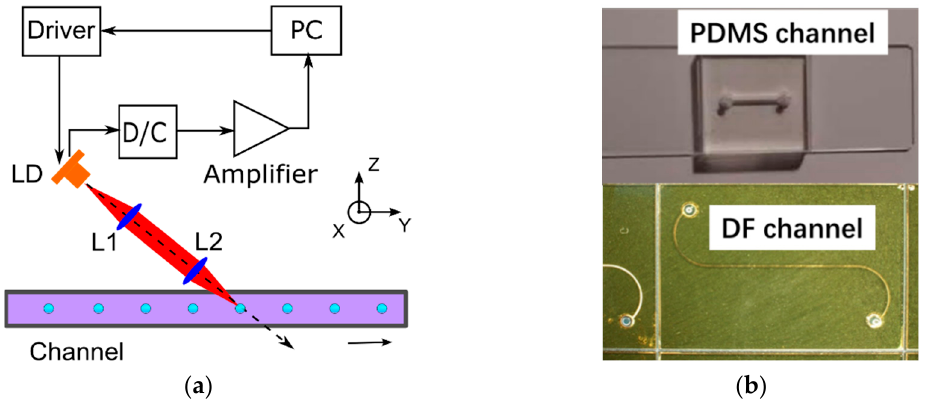
Figure 2. ( a ) Schematic of the microfluidic measurement system; ( b ) a polydimethylsiloxane (PDMS) channel and a dry film (DF) channel.